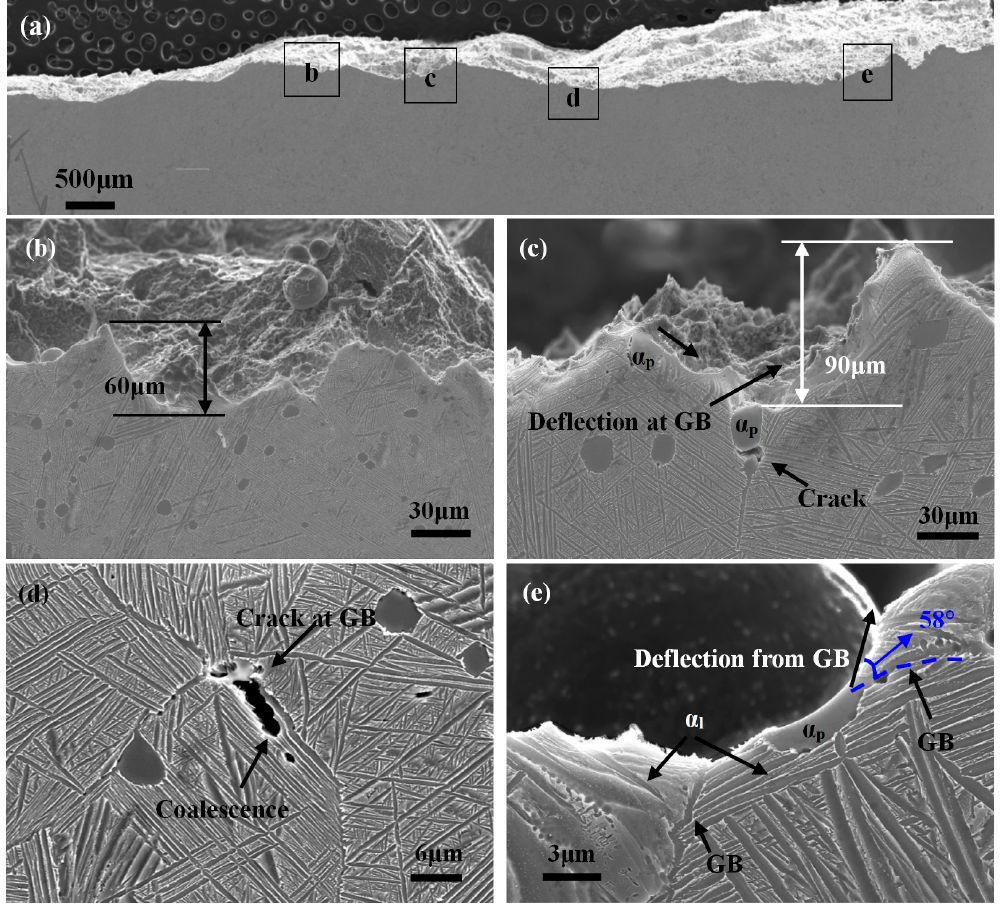
Figure 4. The crack front profiles of the fractured specimen of TM: ( a ) the propagation path of the main crack; ( b ) high fluctuation of about 60 μ m of the propagation path is observed in microregion, ( c ) the crack initiates from the α p interface but not connects with the main crack, which indicates that α P inhibits the crack growth along the GB; ( d ) although the crack forms at the GB, it propagates into the grain interior through connecting with the microcrack in α l , ( e ) the main cracks propagate along the grain boundaries and deviate from grain boundaries with about 58° when encounter α l and α p.